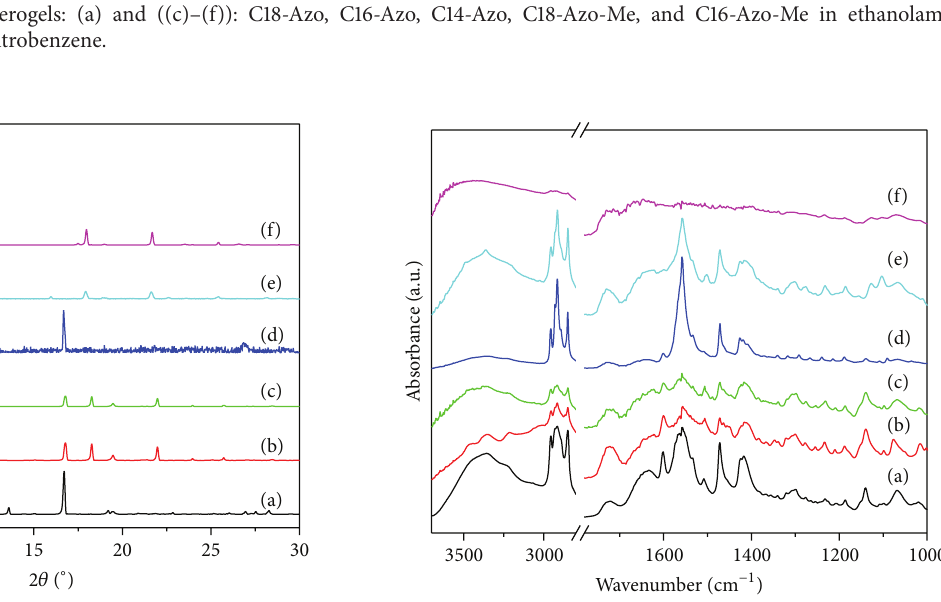
Figure 4: FT-IR spectra of xerogels: (a) and ((c)–(f)): C18-Azo, C16-Azo, C14-Azo, C18-Azo-Me, and C16-Azo-Me in ethanolamine, respectively; (b) C16-Azo in